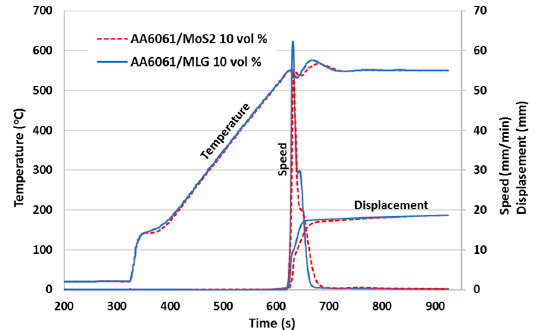
Figure 9. Sintering curves of AA6061/MLG 10 vol % (blue solid line) and AA6061/MoS 2 10 vol % (red dotted line) during the SPT ( λ = 1.5) process.